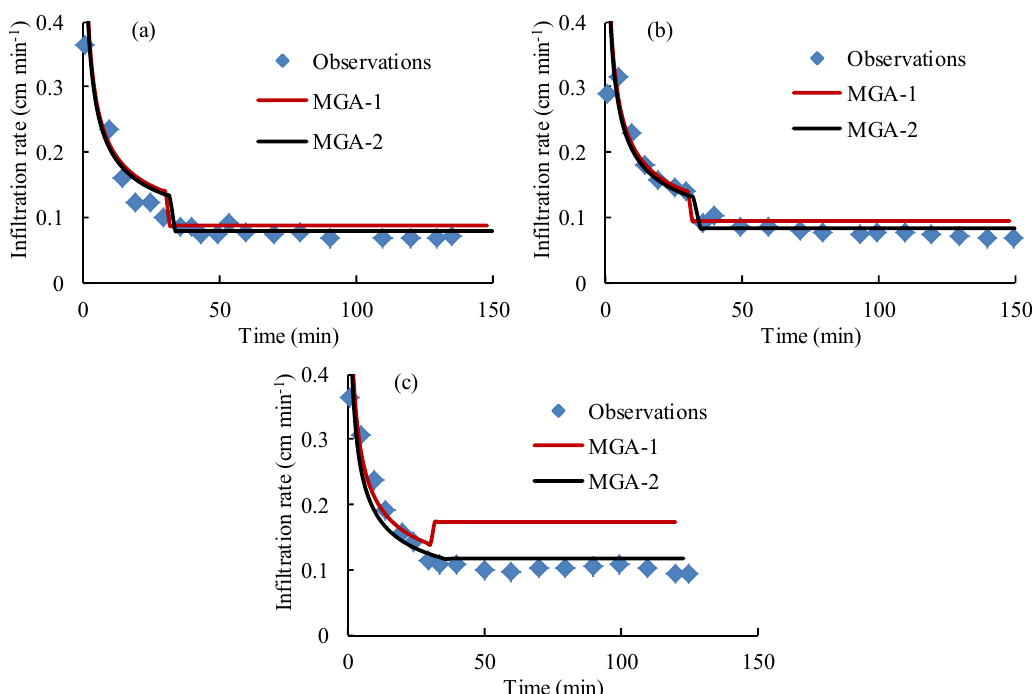
Figure 8. Comparison of the observed infiltration rate and the calculated value with the modified Green-Ampt models for cases ( a ) L1S1L1, ( b ) L1S2L1, and ( c ) L1S3L1 in Experiment I.